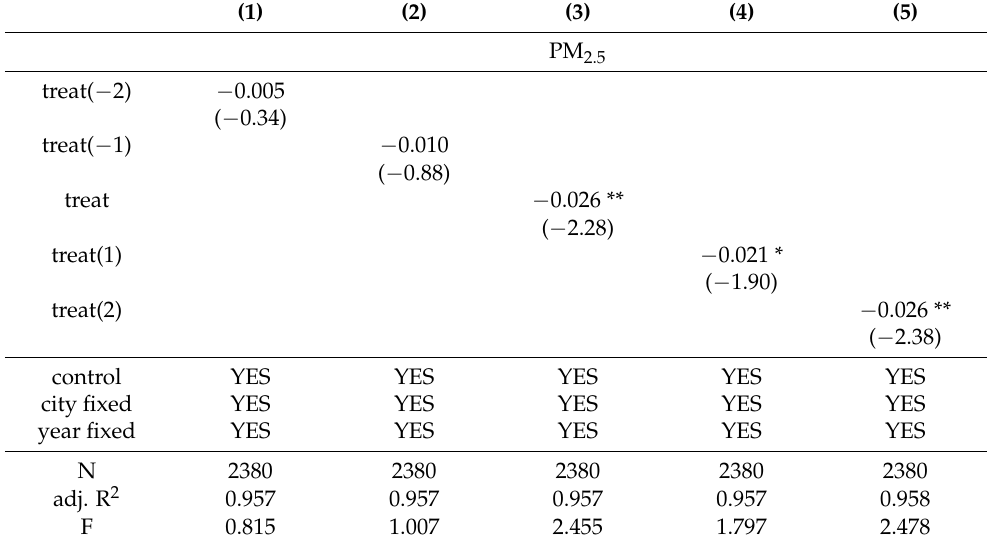
Table 7. Change treatment year analysis.